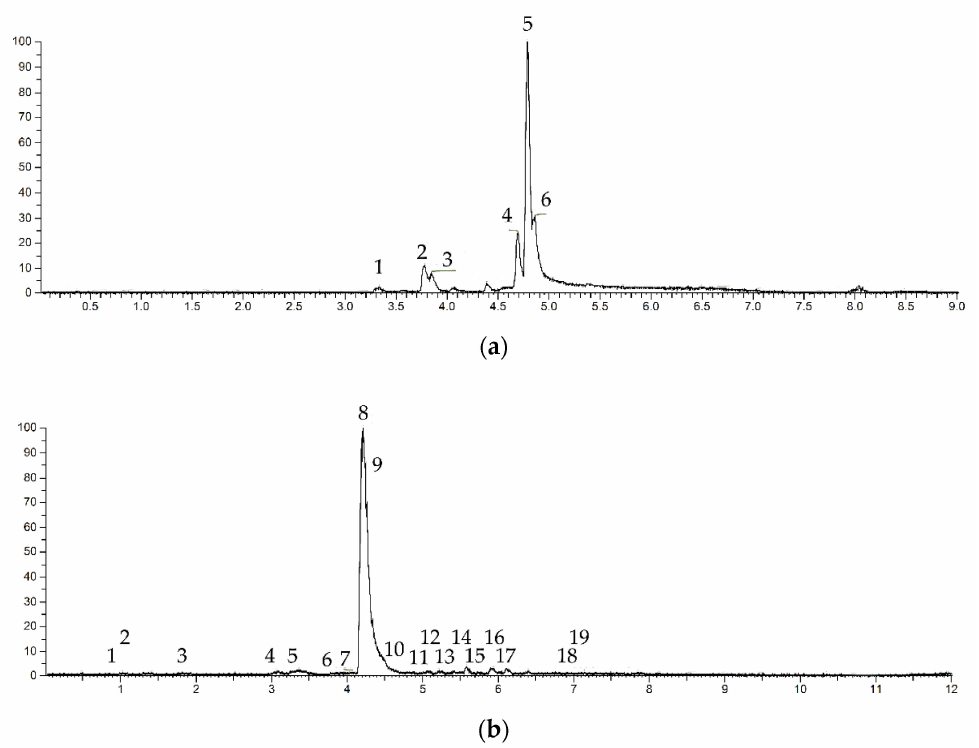
Figure 1. Total ion chromatography of SPLPAs extract. Peaks were identified by UPLC-Orbitrap-MS under negative ion mode. ( a ): The ion chromatograms of chlorogenic acid isomers in SPLPAs extract. ( b ): The ion chromatograms of other phenolic acid compounds in SPLPAs